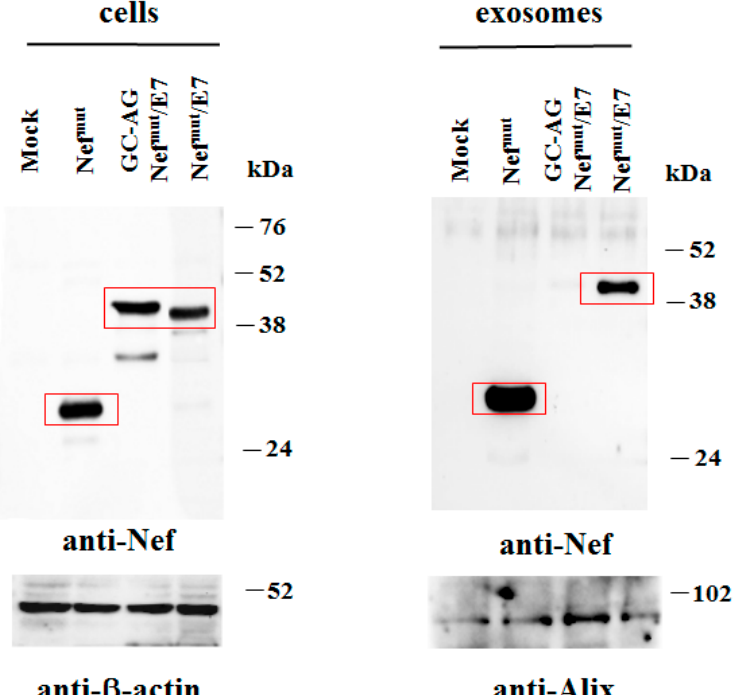
Figure 5. Detection of Nef mut / E7 based fusion products in transfected cells and exosomes. Shown is the Western blot analysis of total lysates from the same number of HEK293T cells transfected with DNA vectors expressing either Nef mut / E7 or GC-AG Nef mut / E7 (left panels). Equal volumes of bu ff er, where purified exosomes were resuspended after di ff erential centrifugations of the respective supernatants, were also analyzed (right panel). As control, conditions from mock-transfected cells, as well as cells transfected with Nef mut alone, were included. Polyclonal anti-Nef Abs served to detect Nef mut -based products, while β -actin and Alix were revealed as markers for cell lysates and exosomes, respectively. Concerning signals from cell lysates, intensity ratios compared to the Nef mut control condition, considering the respective β -actin signals, were 1.05 and 0.91 for GC-AG Nef mut / E7 and Nef mut / E7, respectively. Regarding exosomes, the intensity ratio between Nef mut and Nef mut / E7 conditions, considering the respective Alix signals, was 0.81. Molecular markers are given in kDa. The results are representative of five independent experiments. Uncropped blots showing all the bands with all molecular weight markers are shown in Supplementary Figure S3.